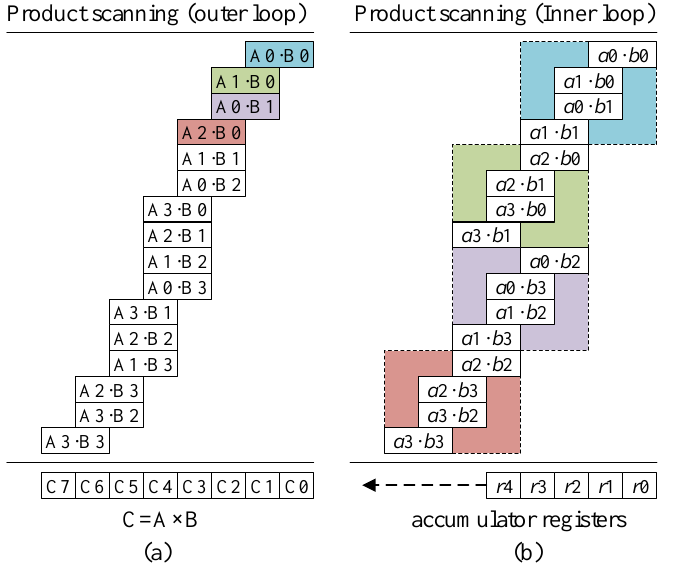
Figure 2. The proposed product scanning multiplication. ( a ) outer loop, an example of 128-bit multiplication. ( b ) inner loop, ( A 0 · B 0, A 1 · B 0, A 0 · B 1, A 2 · B